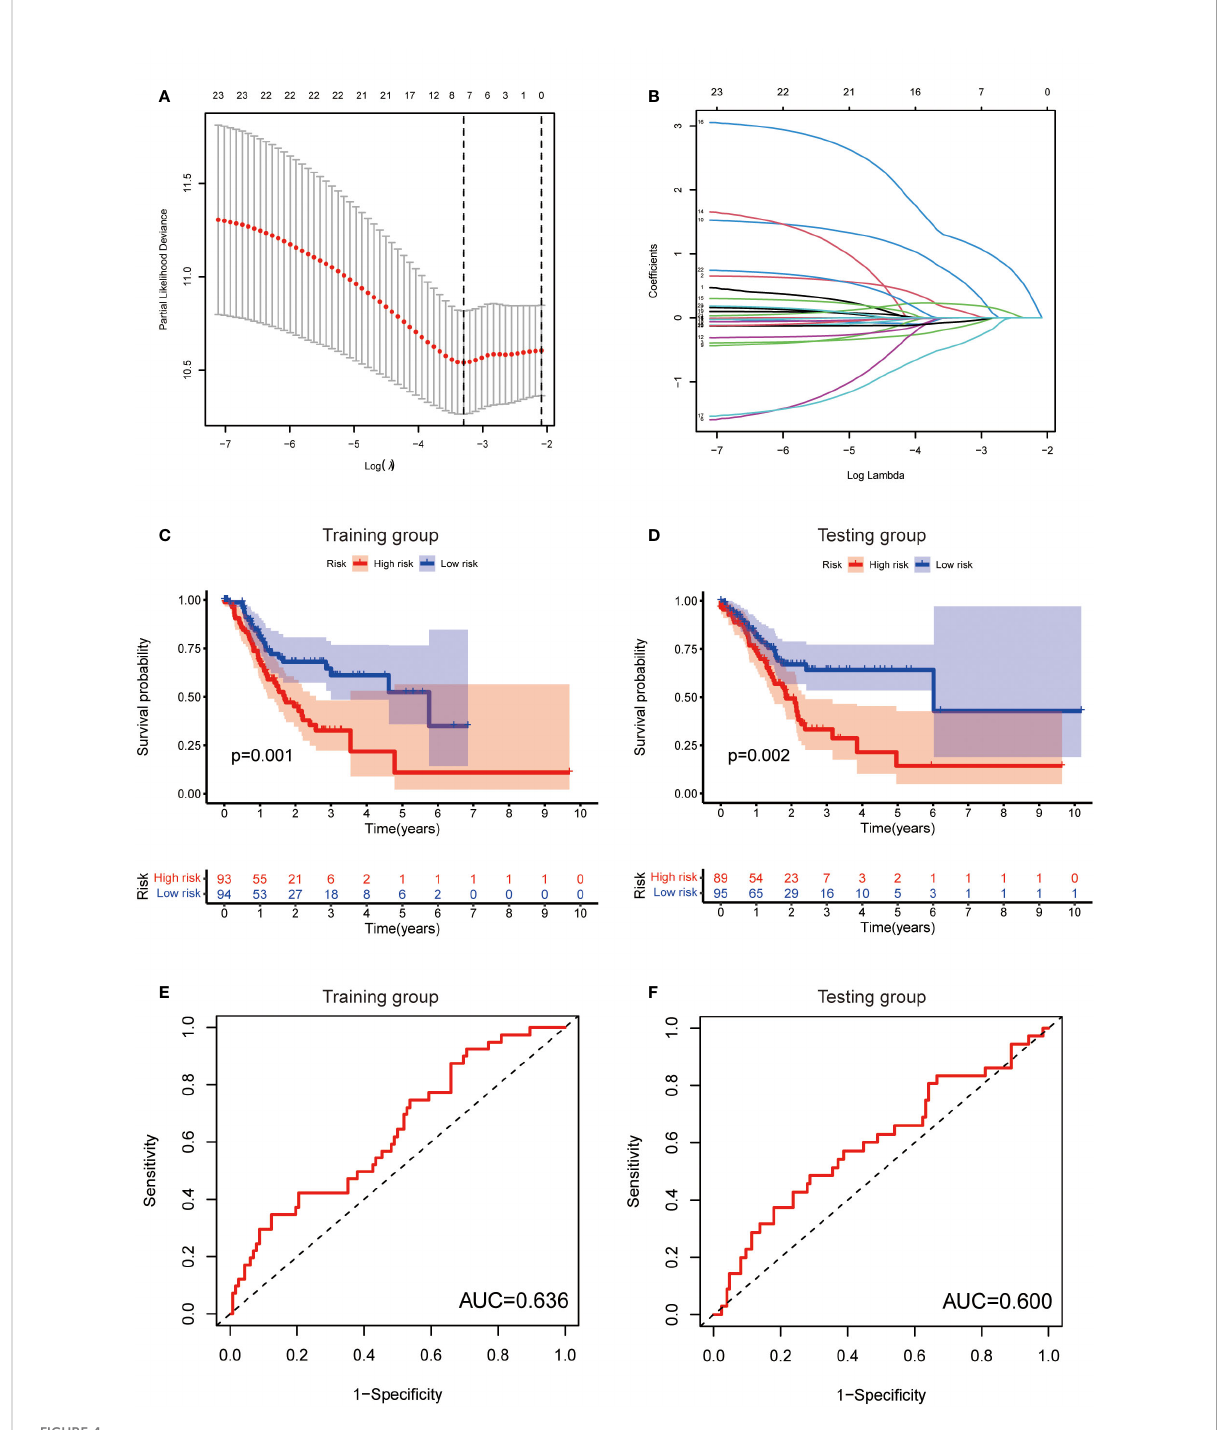
FIGURE 4 Establishment of risk score model. (A) The distribution of lambda and the best options in Lasso analysis (B) The weight of each candidate gene in the model. (C, D) Kaplan-Meier survival curves of the OS of patients between the high- and low-risk groups in the training (C) and testing (D) set. (E, F) The ROC curves of the risk score model in training (E) and testing (F)